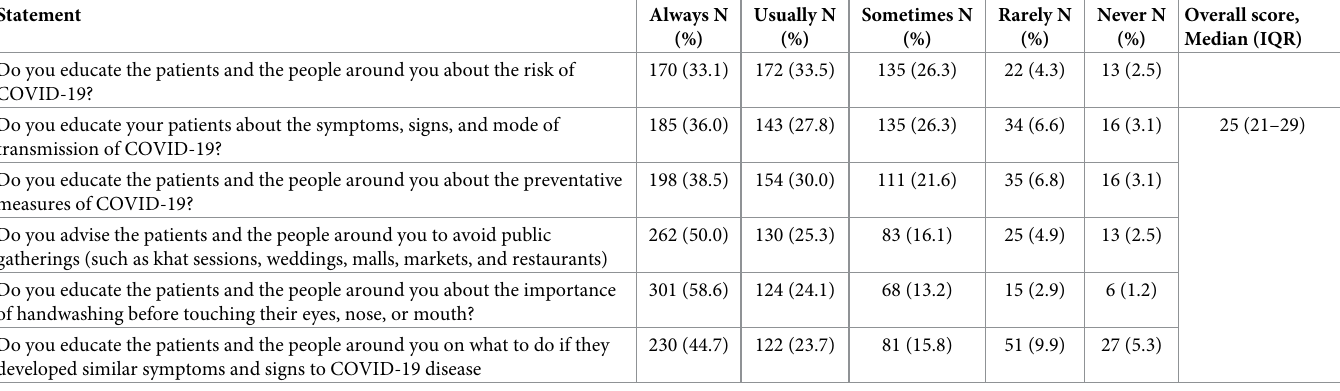
Table 4. Counselling